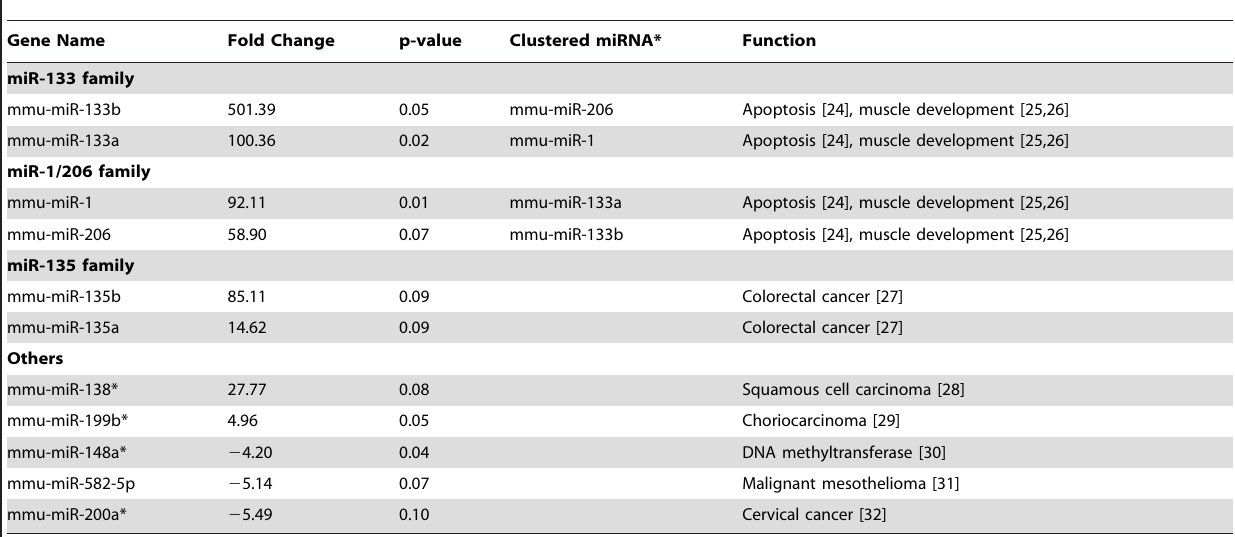
Table 1. Differentially expressed miRNAs in hypothyroid mouse liver (p , 0.1, Fold change . 4).